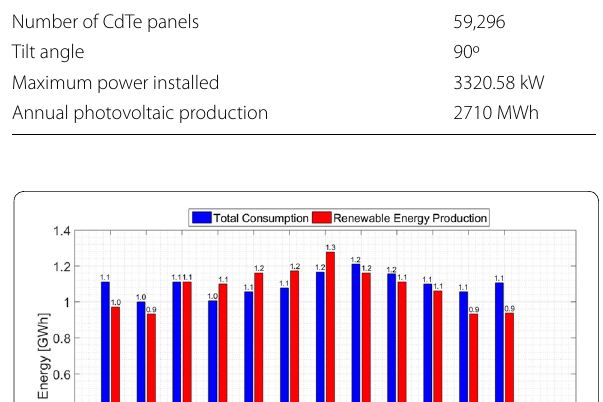
Table 14 Data for cadmium telluride photovoltaic